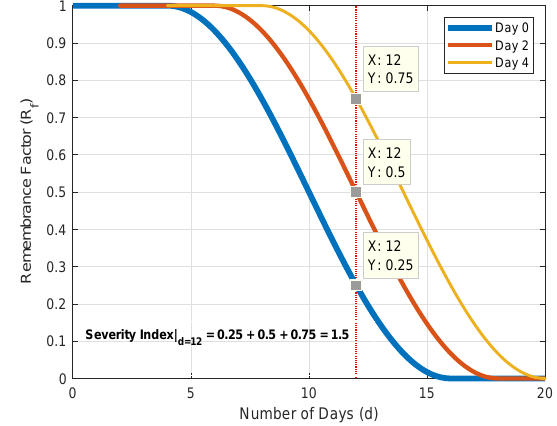
Figure 9. An example calculation of the severity index with three independent reported potholes of a particular location at 0 th , 2 nd , and 4 th day respectively, by setting d act = 4 days, and day − 1 at d = 12 T = 1 20